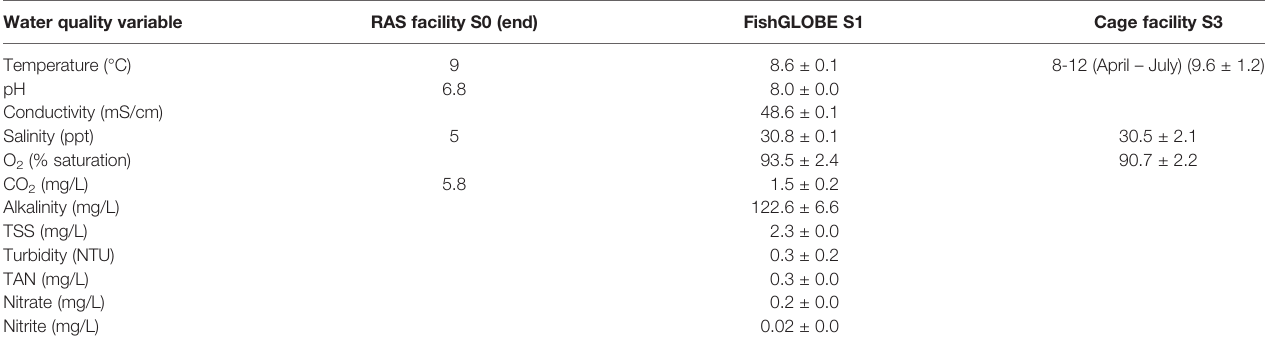
TABLE 1 | Mean ( ± SD) measured water quality variables during end of S0, S1 at 3, 6, and 9 m depth and at 2.3 m and 4.3 m from the centre wall, and S3. Empty cells mean missing data. Water quality